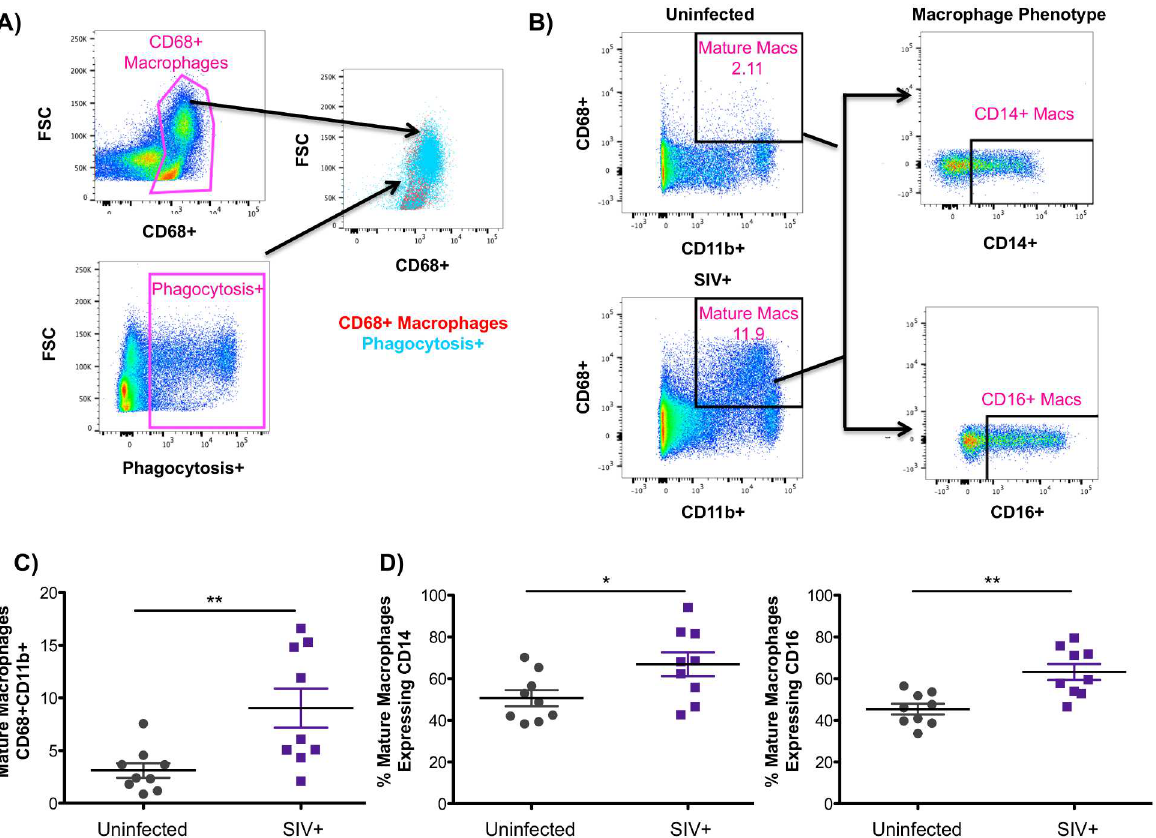
Fig 4. Evaluation of CD68+ mature macrophages in the liver. A) Freshly isolated macaque liver cells were incubated with fluorescently labeled E. coli bioparticles for 2 hours. After washing, cells were evaluated for phagocytosis of E.coli by flow cytometry. Gating first on single, live, CD45+, CD3- cells, CD68+ liver cells were found to be the primary cell subset to phagocytosis E. coli. B) Liver cells suspensions were first gated on single, live, CD45+, CD3- cells. Mature macrophages, identified as CD68+CD11b+, were evaluated for the expression of CD14 and CD16. C) Frequency of mature CD68+CD11b+ macrophages in the liver of uninfected (gray symbols) and SIV-infected (purple symbols) macaques. D) Phenotype of mature hepatic macrophages in uninfected (gray symbols) and SIV-infected (purple symbols) macaques based on CD14 and CD16